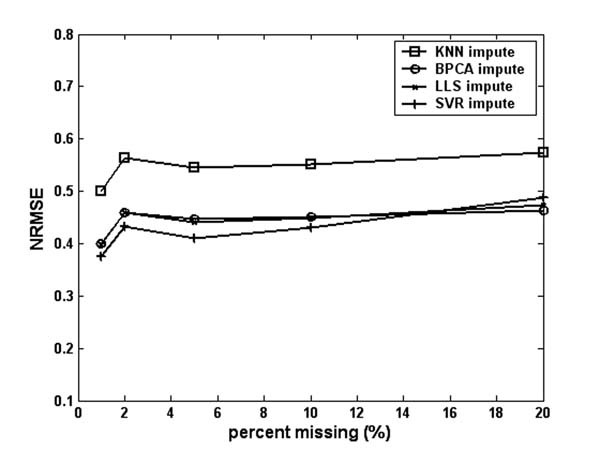
Performance of the four methods on data G.